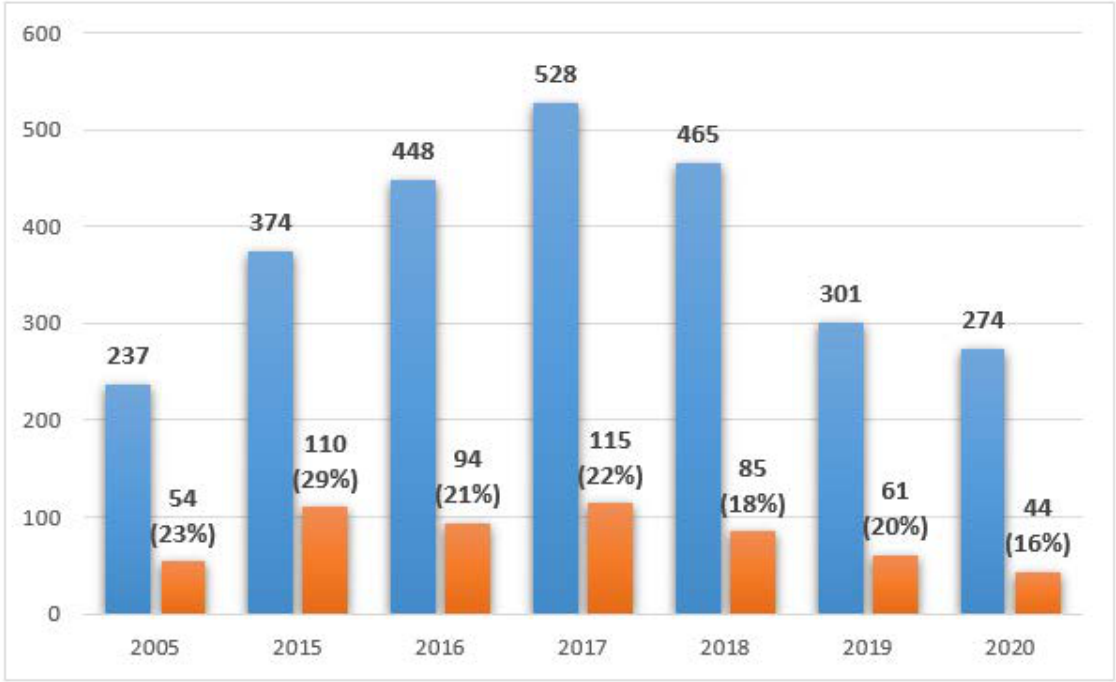
Figure 2. Mycological tests performed in PCICU in the studied years, including positive results. During the studied period, 205 out of 873 mycological tests collected from the NICU were positive. Figure 3 shows the number of collected samples each year divided into five